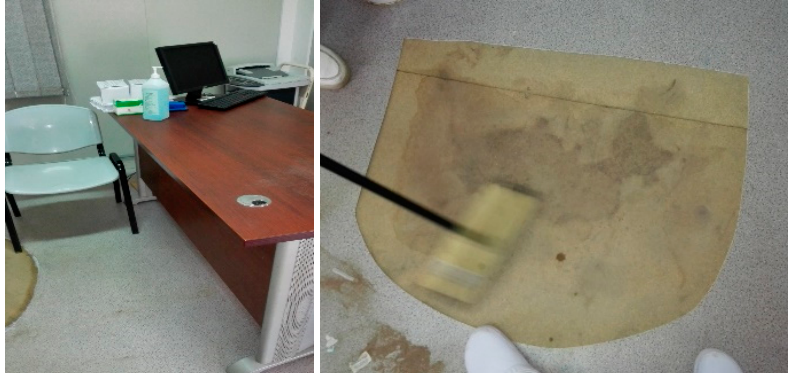
Figure 3. Before (not shown), the physician’s desk was positioned next to the window, with the patient to their right. After, the patient is positioned next to the window and the physician is seated on the opposite side of the desk, allowing the air to flow from the door outside. Ripped flooring has been removed.